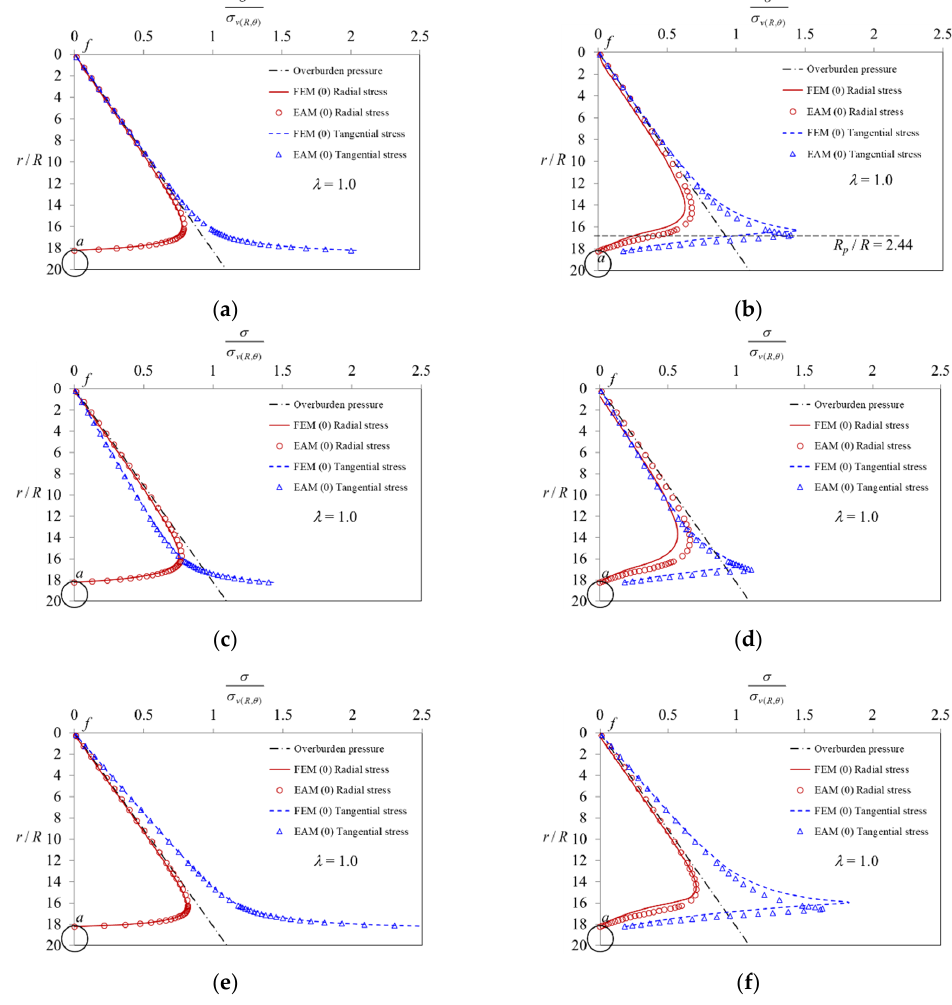
Figure 20. Ground reaction around the tunnel obtained by EAM and FEM in Case I ( θ = 0°) with λ = 1.0, and the distribution of tangential and radial stresses for ( a ) K o = 1.0 in the elastic media, ( b ) K o = 1.0 in the elastoplastic media, ( c ) K o = 0.8 in the elastic media, ( d ) K o = 0.8 in the elastoplastic media, ( e ) K o = 1.2 in the elastic media, and ( f ) K o = 1.2 in the elastoplastic media.